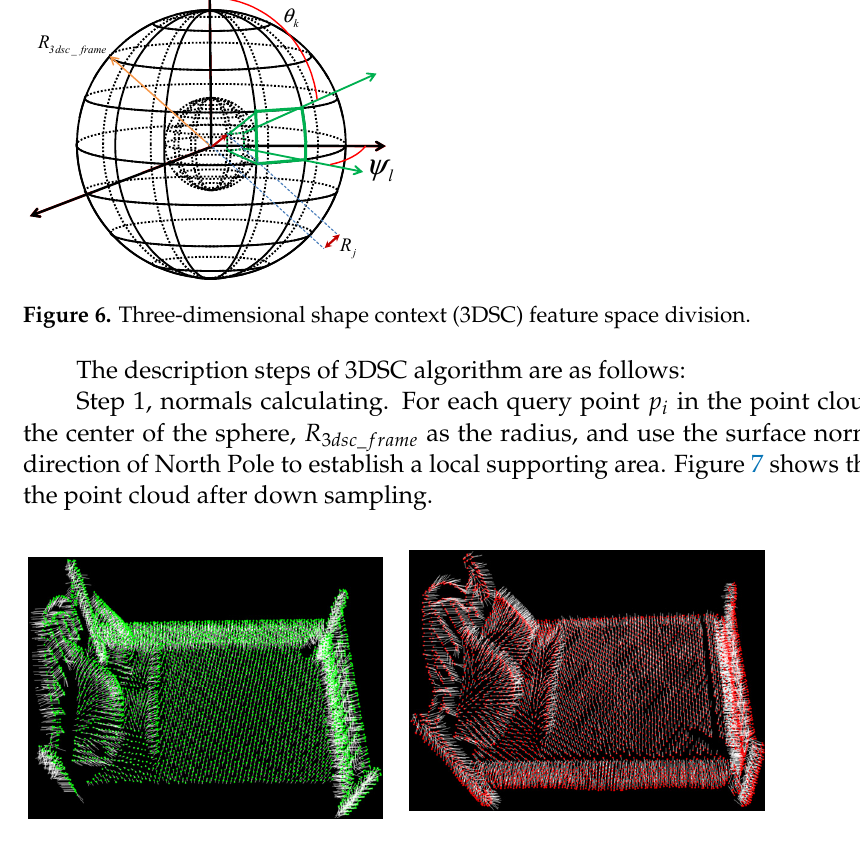
Figure 7. The normals of the point cloud.